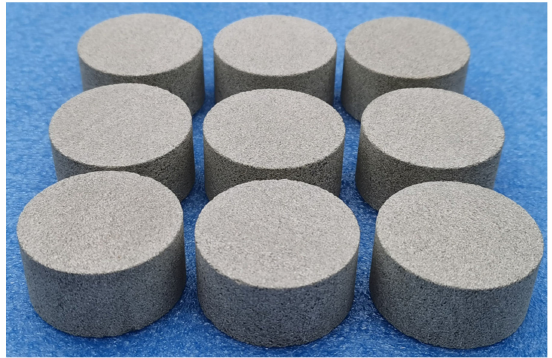
Figure 2. Photograph of disc